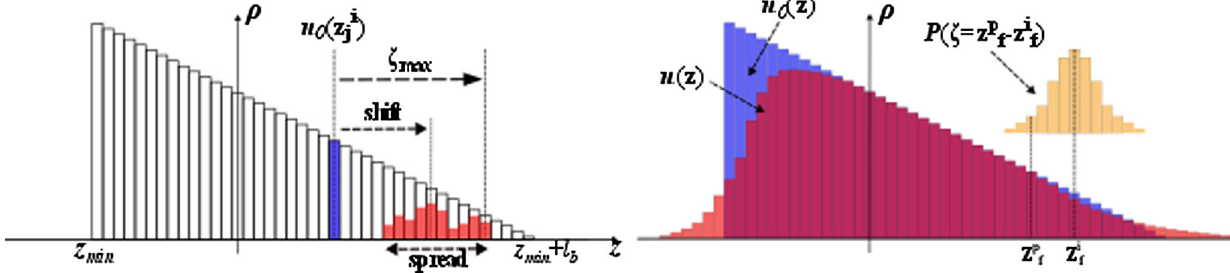
FIG. 5. The general perturbation of a slice (left). The j th slice of the ideal longitudinal bunch shape has n 0 ð z i j Þ particles at the ideal position ( z i j ). In general, P ð ζ Þ shifts particles in the slice to new locations by a spread of distances. The total perturbed bunch shape, n ð z Þ , is due to the sum of all the slice perturbations (right).